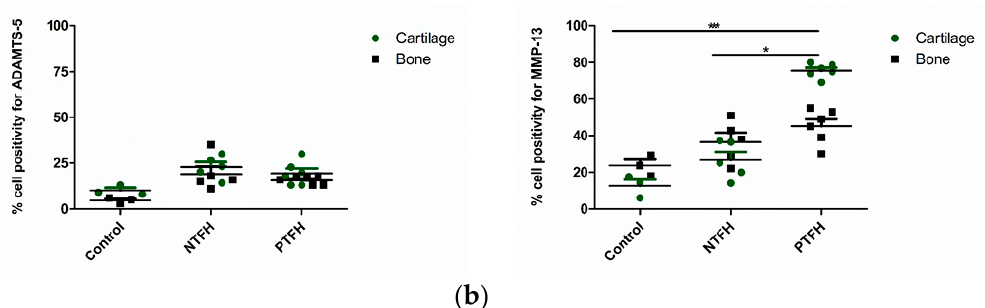
Figure 4. ( a ) Immunostaining for ADAMTS-5 and MMP-13 in osteochondral tissues from the control, NTFH and PTFH groups. Scale bar = 50 µ m. Black arrows show positive cells. ( b ) Graphical representations of the percentage of positivity for ADAMTS-5 and MMP-13. Data are expressed in a scatter plot graph with mean ± standard deviation (SD). MMP-13: ** p < 0.001: Control versus PTFH group; * p < 0.05: NTFH versus PTFH group.